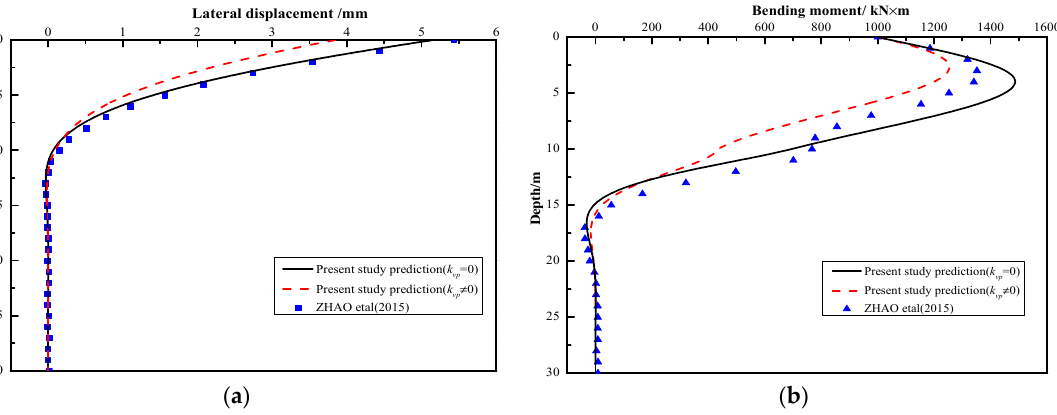
Figure 9. Comparison of lateral displacement and bending moment in Case Study 2 ZHAO et al. [41]. ( a ) Lateral displacement/mm; ( b ) bending Moment/kN × m. ( a ) Lateral displacement/mm; ( b ) bending Moment/kN ×